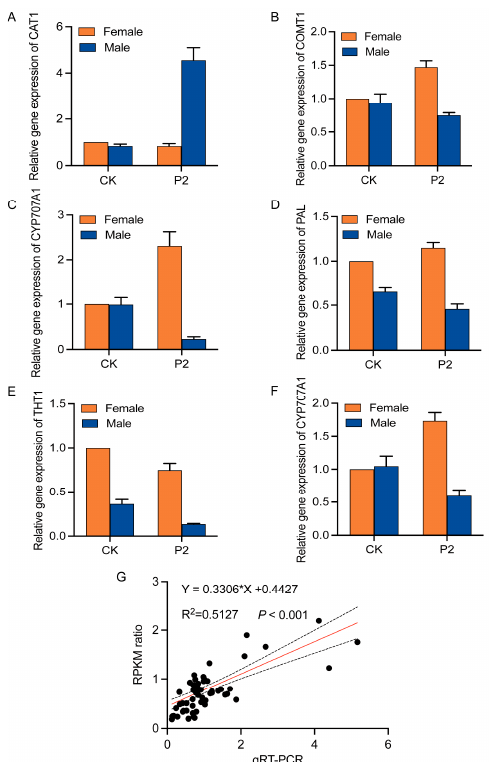
Figure A1. Correlations between the DEG expression patterns obtained by RNA-Seq and qRT-PCR ( A – F ); and relative expression levels of six DEGs under Pb stress as determined by qRT-PCR ( G ). Comparison between the log 2 of gene expression ratios obtained from RNA-Seq data and qRT-PCR value. The qRT-PCR value of the expression ( x -axis) was plotted against the value from the RNA-Seq ( y -axis). R 2 represents the correlation coefficient between qRT-PCR and RNA-Seq. Table A1. Primers used for qRT-PCR.